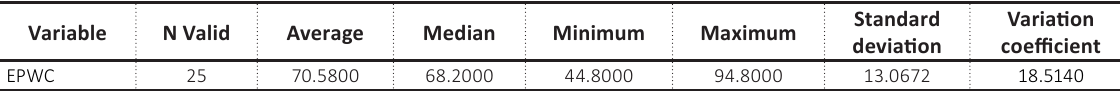
Table 4. Descriptive statistics on the indicator “employed persons who can easily take one or two days off at a short notice by working at home”, by